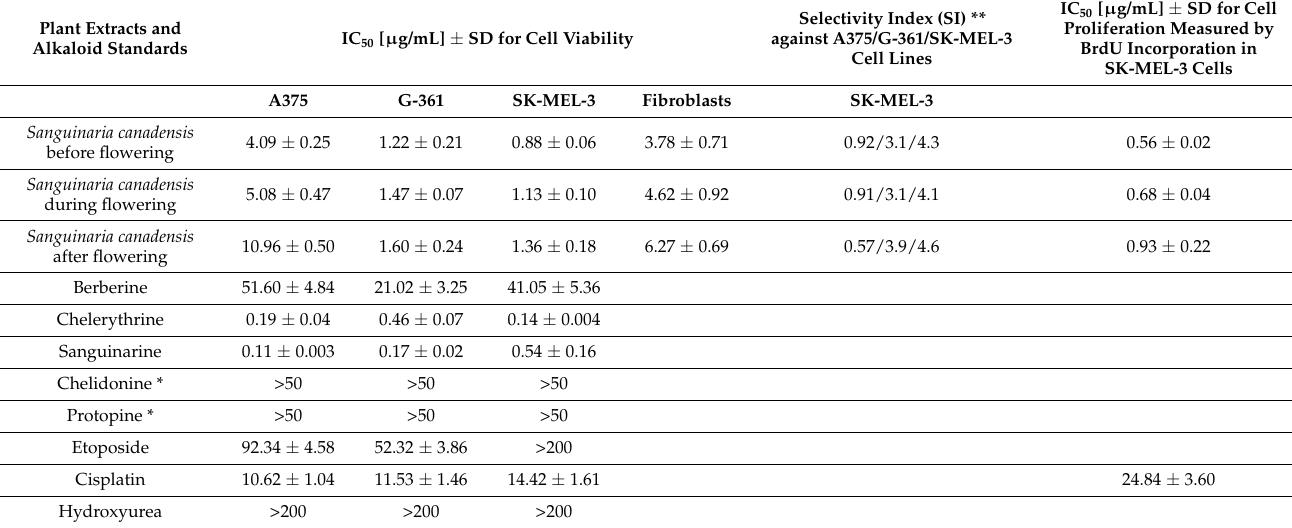
Table 3. Selectivity index (SI), cytotoxic activity, expressed as IC 50 values of the investigated extracts, alkaloid standards, and anticancer drugs against three melanoma cell lines (A375, G361, SK-MEL-3). Plant Extracts and µ g/mL] ± SD for Cell Alkaloid Standards IC 50 [